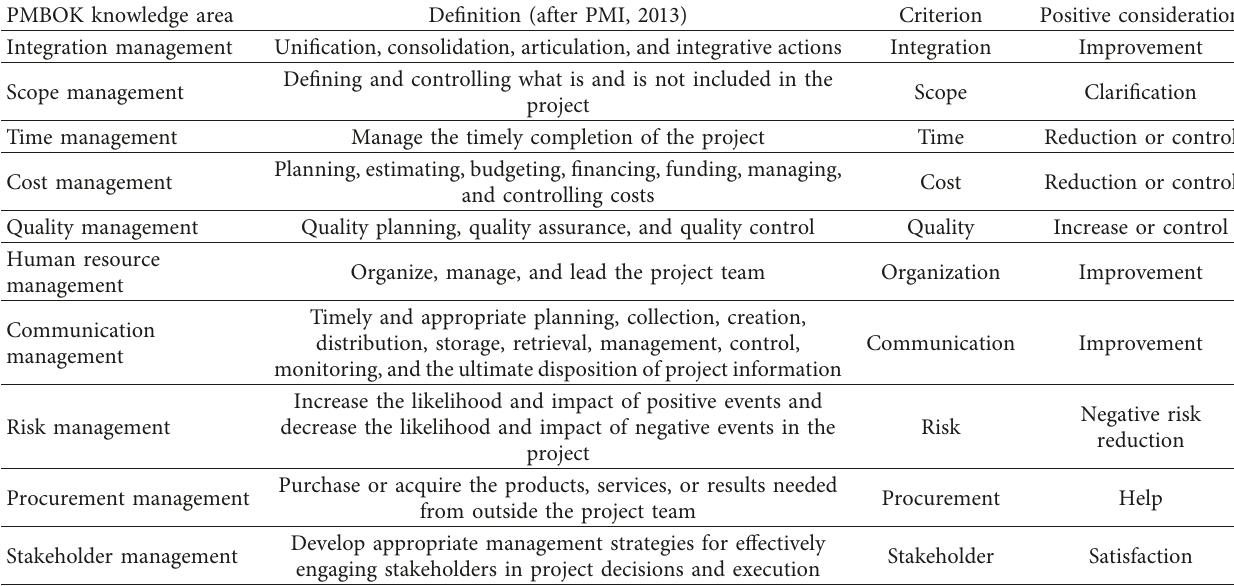
Table 1: Success criteria based on PMBOK knowledge